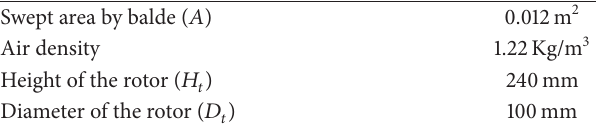
Table 3: Parameters of Darrieus turbine.